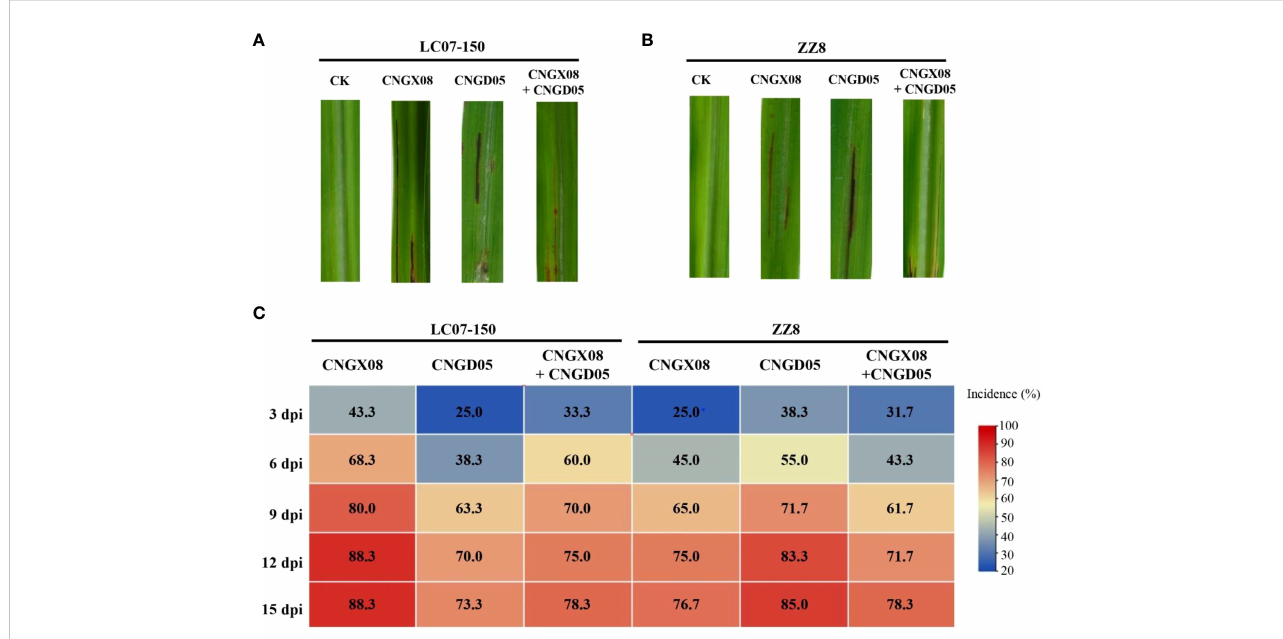
FIGURE 3 Symptoms and disease incidence of red stripe in two sugarcane varieties (LC07-150 and ZZ8) inoculated with strains CNGX08 and CNGD05 of Acidovorax avenae subsp. avenae. (A) Red stripe symptoms observed 15 days post inoculation (dpi) in variety LC07-150, CK = water control. (B) Red stripe symptoms observed 15 dpi in variety ZZ8, CK = water control. (C) Heatmap of disease incidence of inoculated plants from 3-15